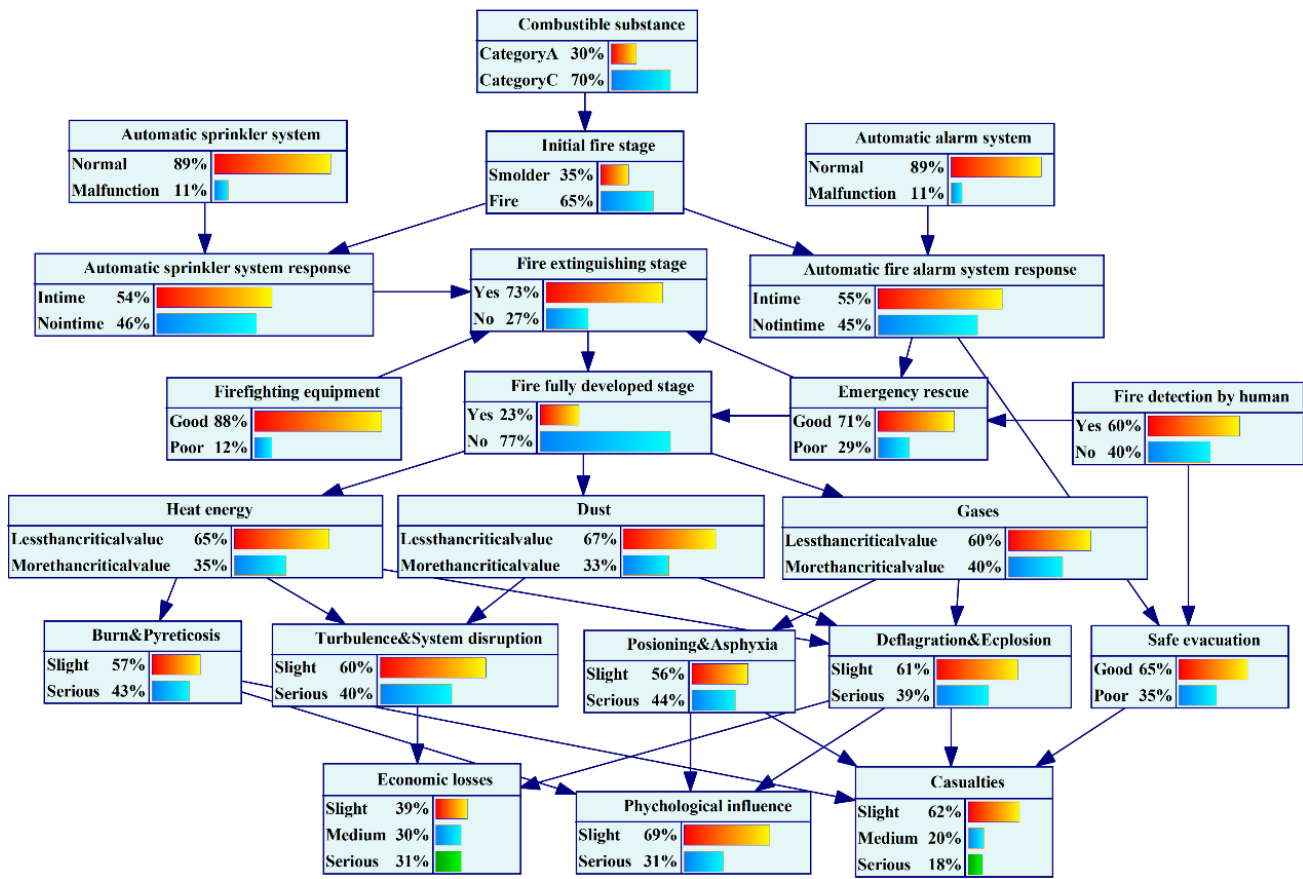
Figure 7. The BN of UEF.